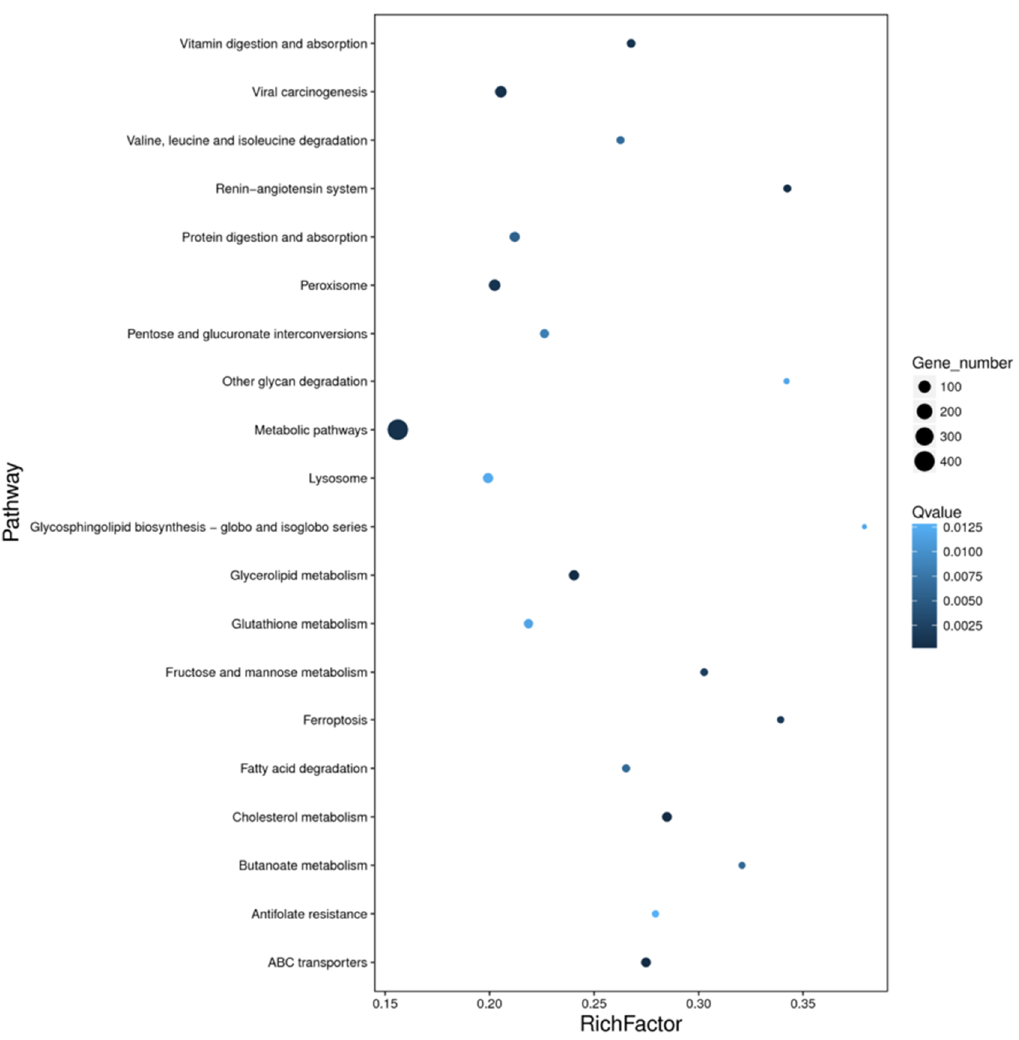
Figure 6. Scatter plot of the KEGG enrichment of differential genes. The vertical axis represents the name of the pathway, the horizontal axis indicates the rich factor, the size of the dot represents the number of differentially expressed genes in a given pathway, and the colors of the dots correspond to different Q value ranges.